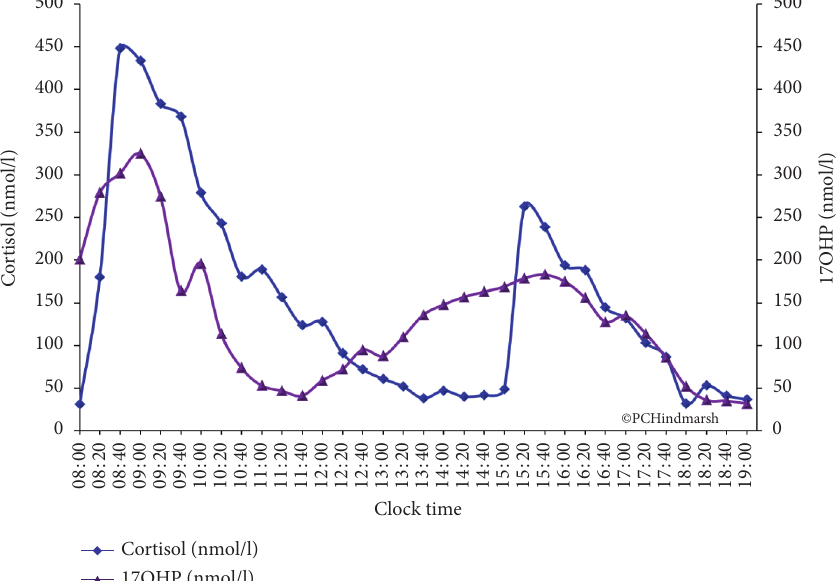
Figure 7: Temporal relationship between cortisol (blue line and diamonds) and 17 hydroxyprogesterone (purple line and triangles) in a 12- year old pubertal female with salt-wasting congenital adrenal hyperplasia following the administration of hydrocortisone at 08.00h (5mg) and 14.30h (2.5mg) (daily dose 11mg/m2/day) showing the lag between the peak cortisol concentrations at 08:40 h and 15: 20h and effect on plasma 17 hydroxyprogesterone concentrations. Blood samples are drawn at 20-minute intervals. Reproduced from Congenital Adrenal Hyperplasia: A Comprehensive Guide, Hindmarsh P and Geertsma K Elsevier, New York (2017).